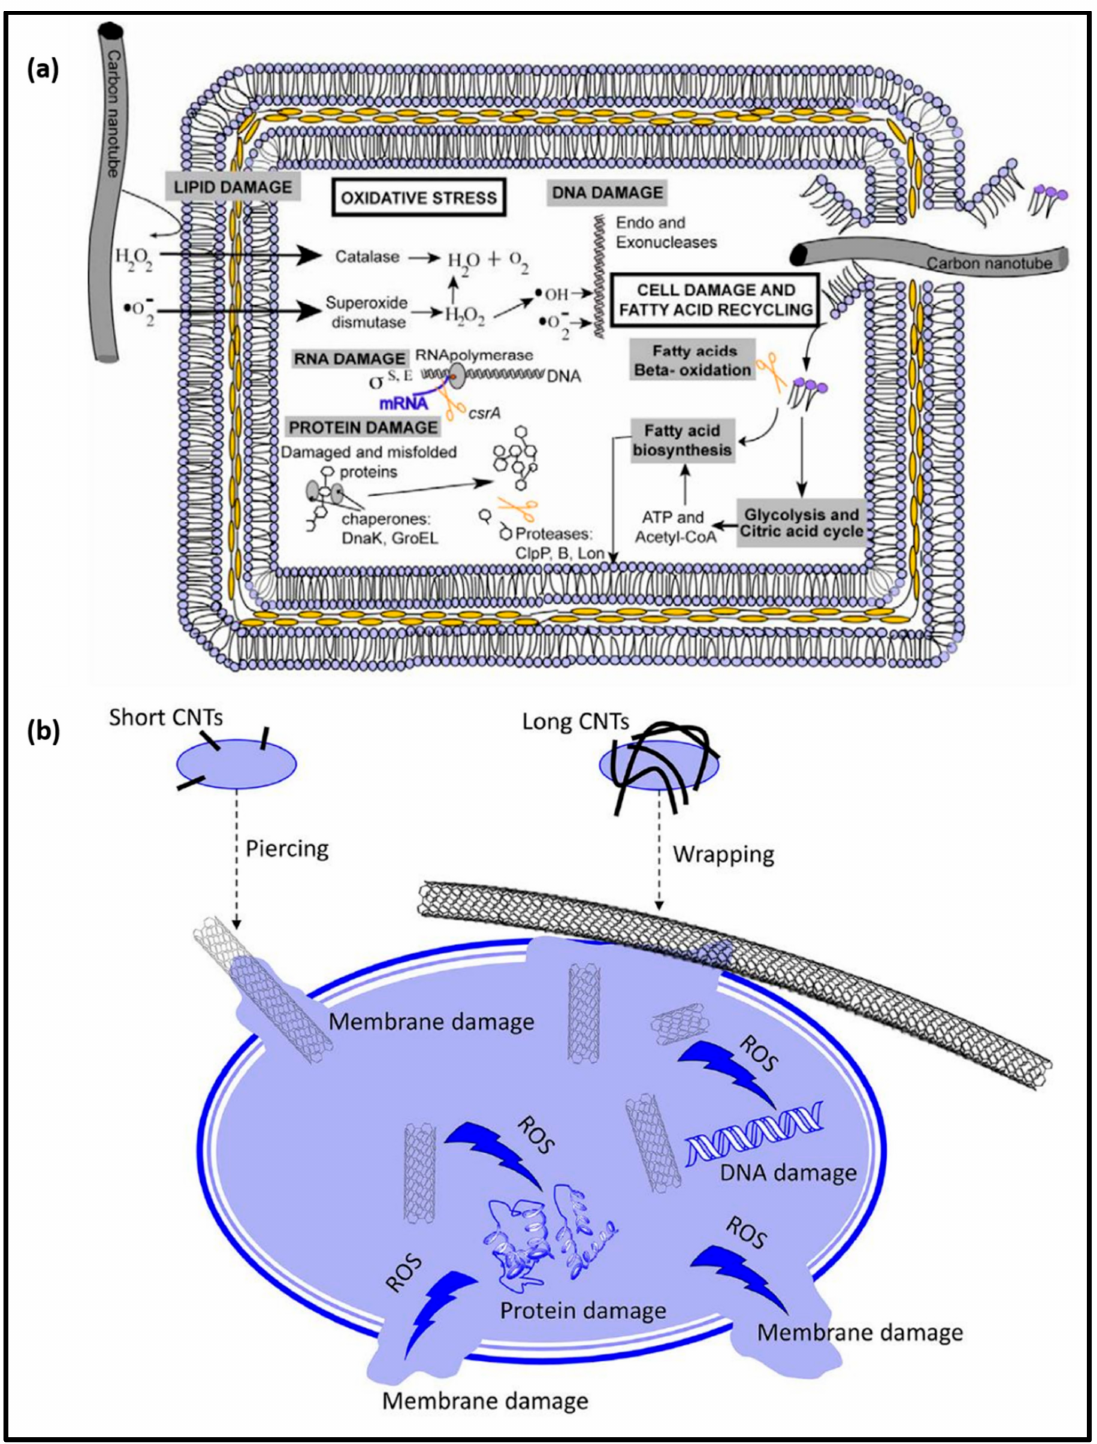
Figure 4. ( a ) Scheme showing antibacterial activity through cell membrane rupture in E. coli K12 bacteria [103], ( b ) Schematic diagram of bacteria killing through ROS mechanism in presence of long and short CNT